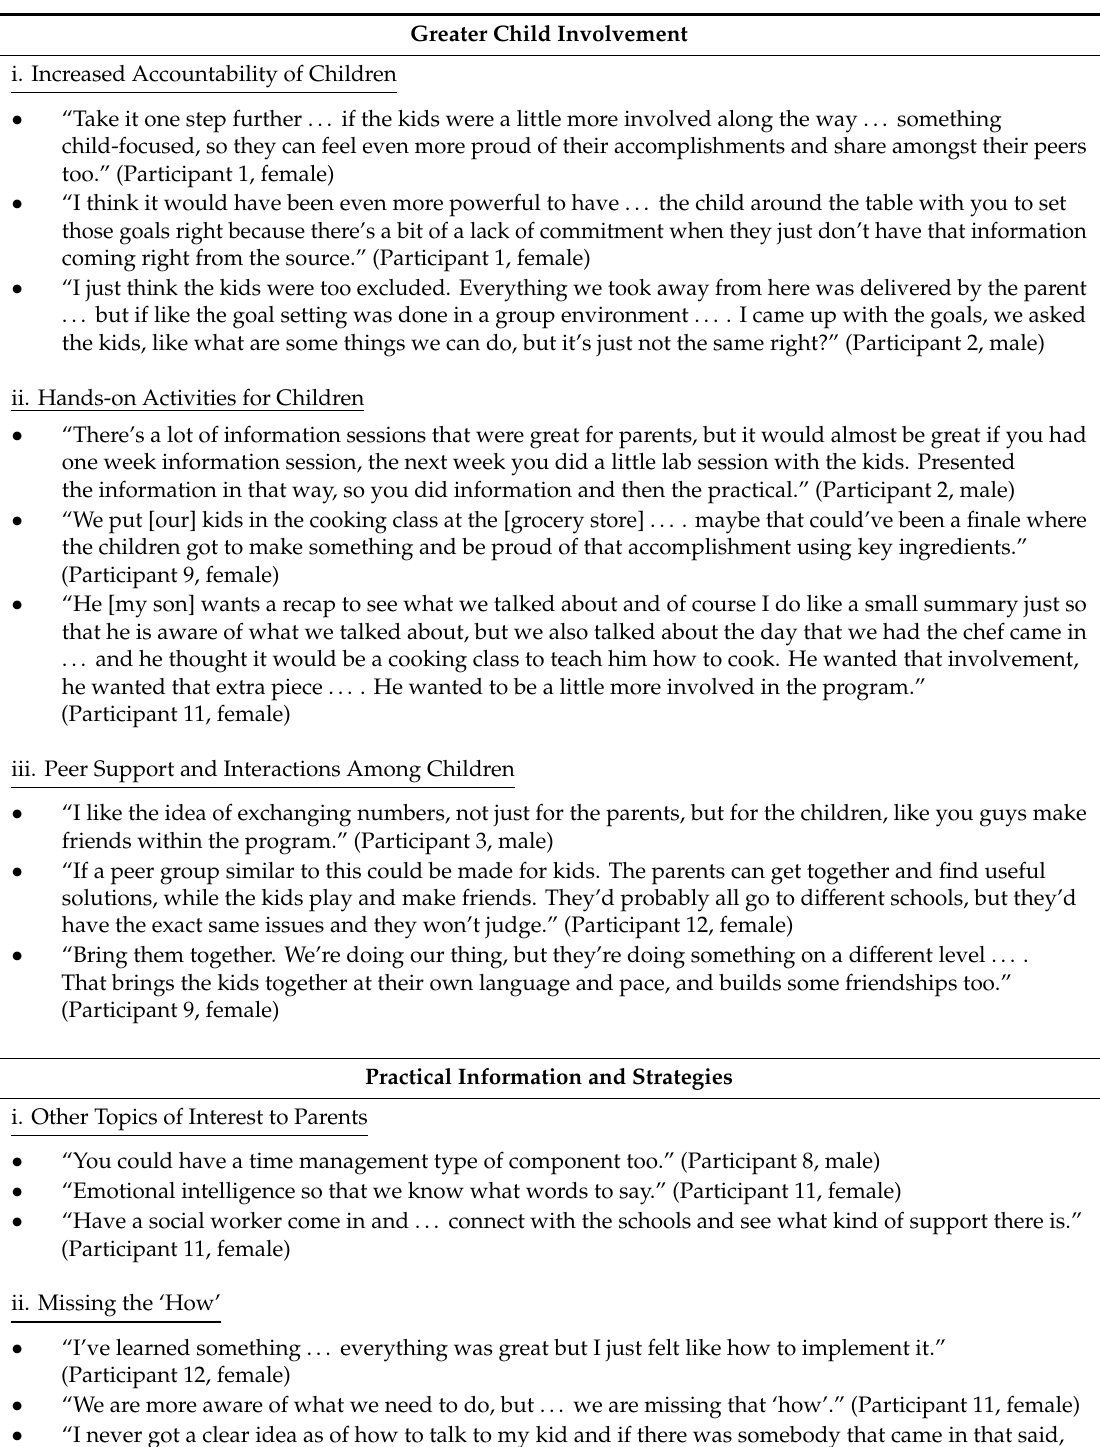
Table 6. Selected quotes related to parents’ recommendations for future paediatric overweight / obesity